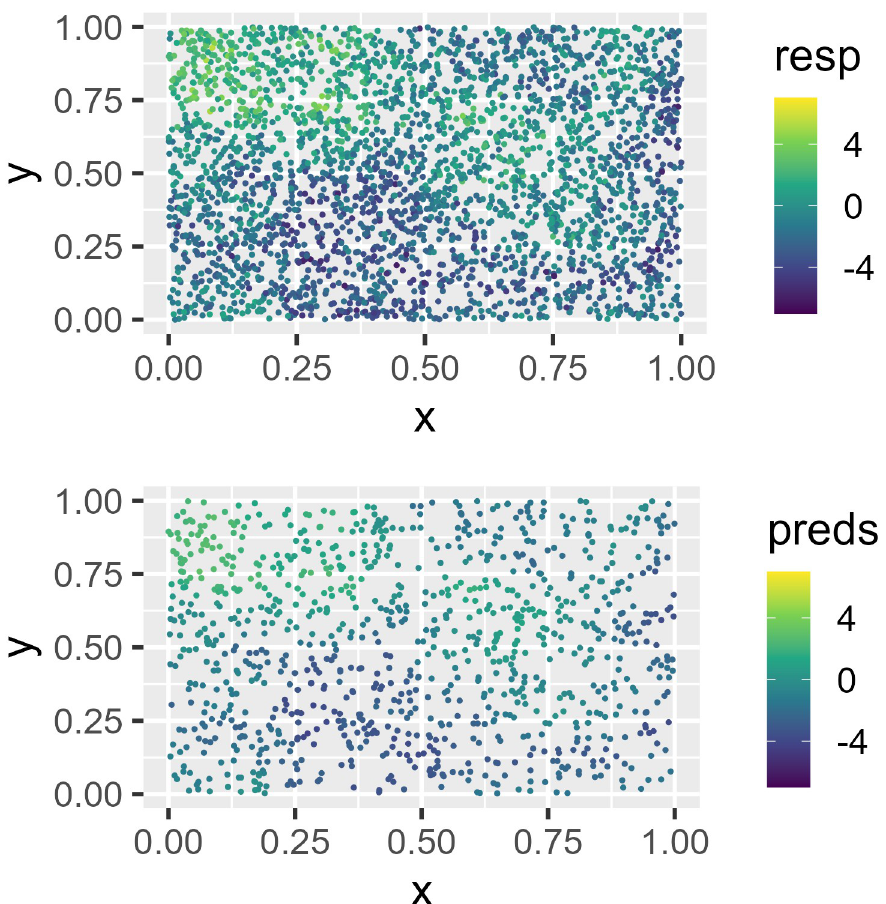
Fig 6. Observed data and big data predictions at unobserved locations. In A (top), spatial data are simulated in the unit square. A spatial linear model is fit using the default big data approximation for model-fitting. In B (bottom), predictions are made using the fitted model and the default big data approximation for